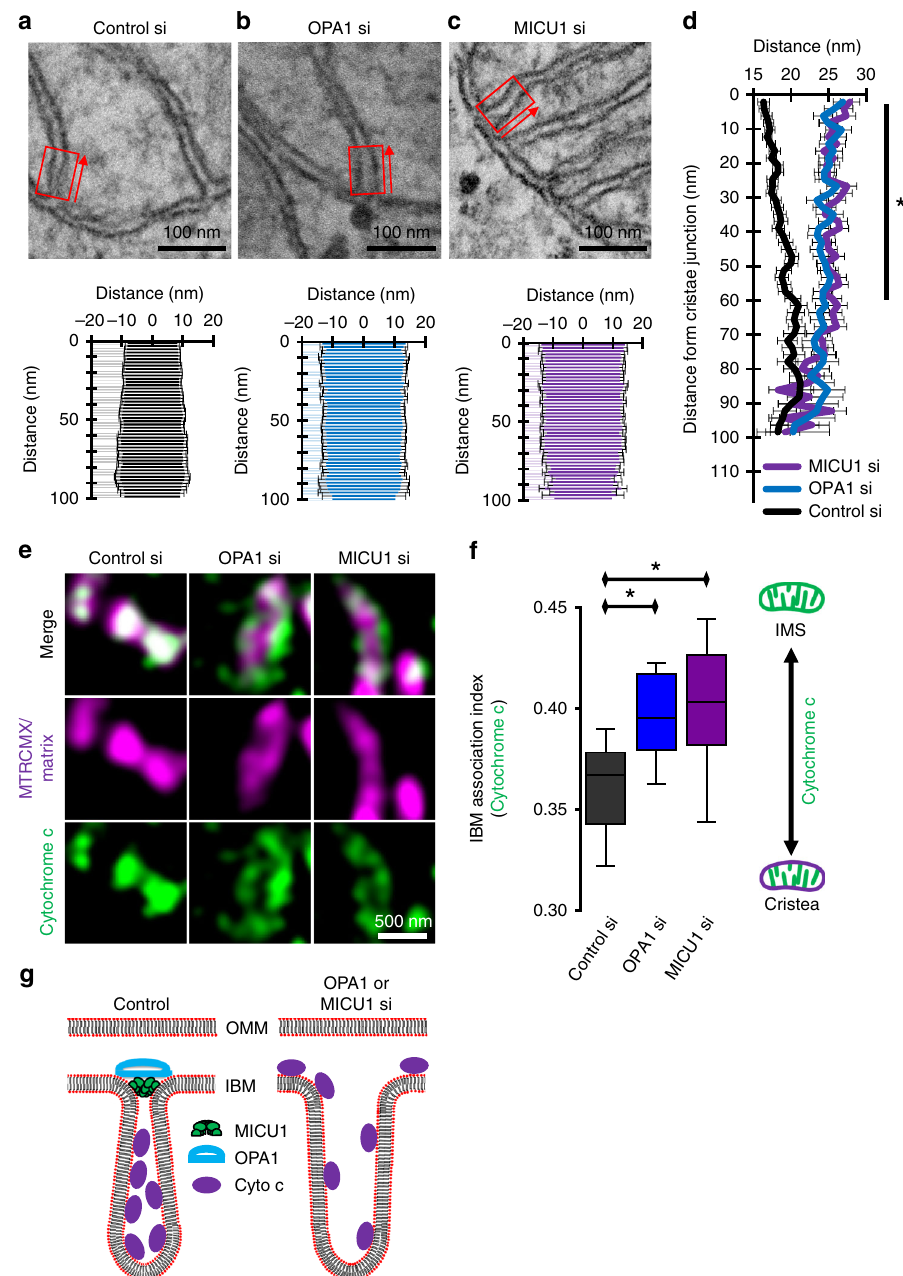
Fig. 4 OPA1 and MICU1 tighten the CJ to restrict cytochrome c release from the cristae lumen. a The upper panel shows a single TEM image of a mitochondrion of HeLa cells transfected with control-siRNA (Control si). To analyze the topology of the cristae junction the cristae width was measured in 2 nm increments starting at the thought prolongation of the IBM and measured into the cristae as indicated with red boxes and arrows in a – c . In the lower panel the distance of the CM to the cristae center is plotted against the distance from the IBM ( n = 2/24/117 with preparations/cells/CJ). b Same experiment as in a but with OPA1-siRNA (OPA1si) ( n = 2/22/97 with preparations/cells/CJ). c Same experiment as in a but with MICU1-siRNA (MICU1si) ( n = 2/23/106 with preparations/cells/CJ). d Comparative analysis of the cristae junction topology of Control ( a , black), MICU1 ( c , magenta) and OPA1 ( b , blue) siRNA transfected cells. Data points represent the mean ± SEM ( n Control si = 117; n OPA1 si = 97; n MICU1 si = 106). e Representative images of HeLa cells transfected with Control, OPA1, or MICU1 siRNA, stained with MTRCMX, PFA- fi xed and immunostained for cytochrome c. f Quantitative analysis of the sub-mitochondrial distribution of cytochrome c in HeLa cells transfected with Control, OPA1, or MICU1 siRNA ( n = 12). Horizontal lines represent the median, the lower and upper hinge show respectively fi rst quartile and third quartile, and lower and upper whisker encompass minimal and maximal values. g Schematic representation of the impact of the loss of MICU1 or OPA1 on mitochondrial cytochrome c redistribution caused by enlarged cristae junction. * P < 0.05 vs. respective control conditions carried out with analysis of variance (ANOVA) with Bonferroni post hoc test. Source data are provided as a Source Data fi